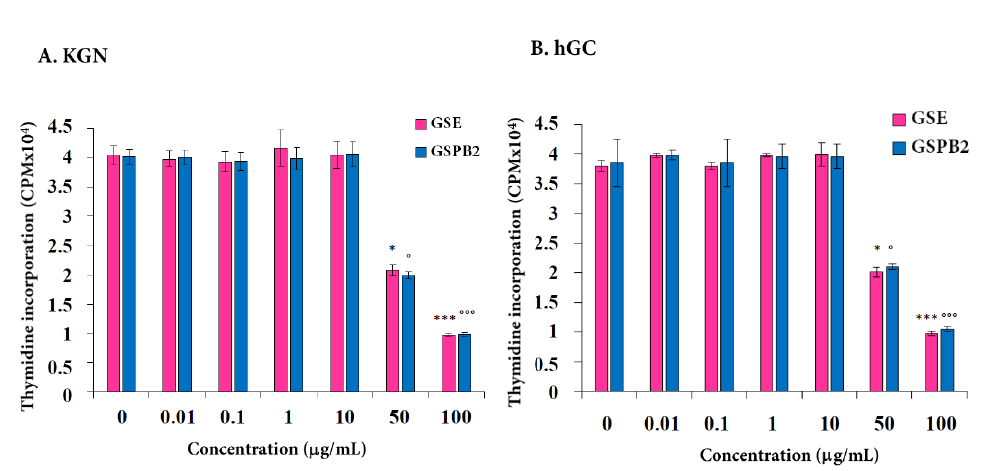
Figure 1. Effect of grape seed extract (GSE) and dimeric proanthocyanidin B2 (GSPB2) treatments on cell proliferation in human granulosa cells. Thymidine incorporation was determined in human granulosa cells (KGN) ( A ) and primary luteinized human granulosa cells (hGC) ( B ) cultured for 24 h in appropriate medium with 10% FBS supplemented with or without different concentrations of GSE and GSPB2 (0, 0.01, 0.1, 1, 10, 50, and 100 µ g / mL). CPM: counts per minute. Results are represented as mean ± SEM. The results are representative of four independent cultures with each condition in quadruplet. For the hGC cells, an independent culture was from a pool of cells collected from three patients. * and *** represent a significant effect of GSE as compared to the control at p ≤ 0.05 and p ≤ 0.001, respectively. ◦ and ◦◦◦ represent a significant effect of GSPB2 as compared to the control at p ≤ 0.05 and p ≤ 0.001,